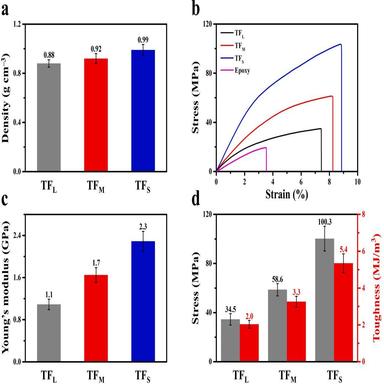
(a) Density of TFL, TFM and TFS. (b) Stress-strain curves of TFL, TFM, TFS and epoxy. (c) Young's modulus, and (d) tensile strength and toughness of TFL, TFM and TFS.